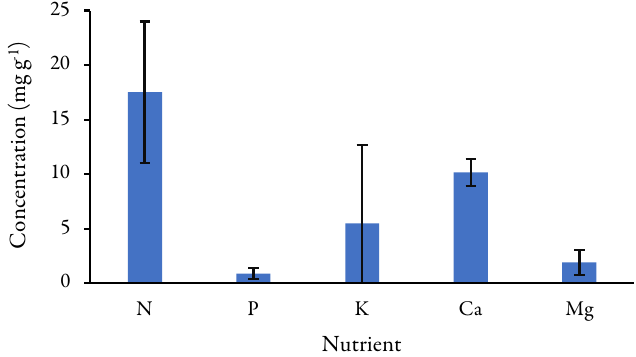
Figure 2. Macronutrient concentrations (mean ± standard deviation) in Nepenthes macfarlanei at the Genting Highlands,